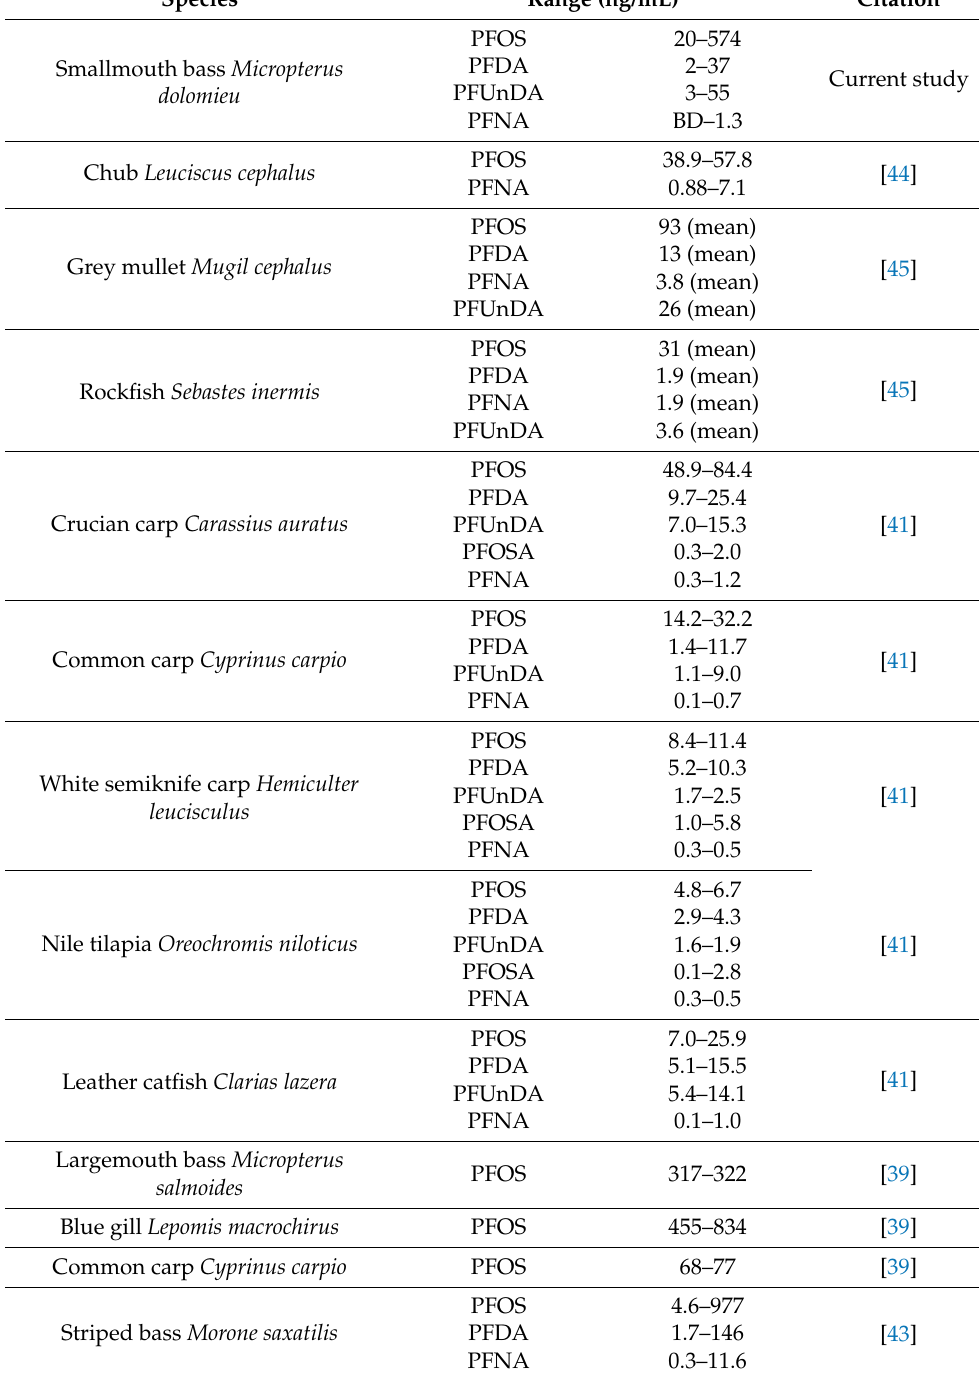
Table 6. Comparison of plasma, serum or blood perfluoroalkyl concentrations in fish species world- wide as reported in the